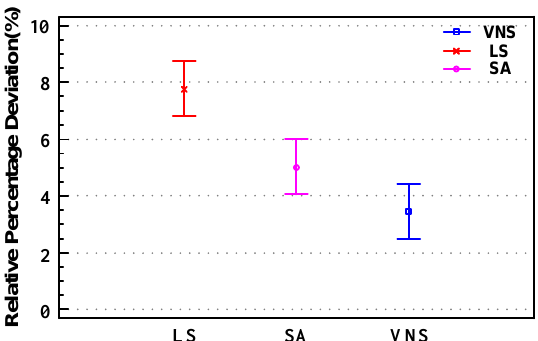
Figure 4. The mean plot of the three compared algorithms with 95.0 percent Tukey HSD intervals.